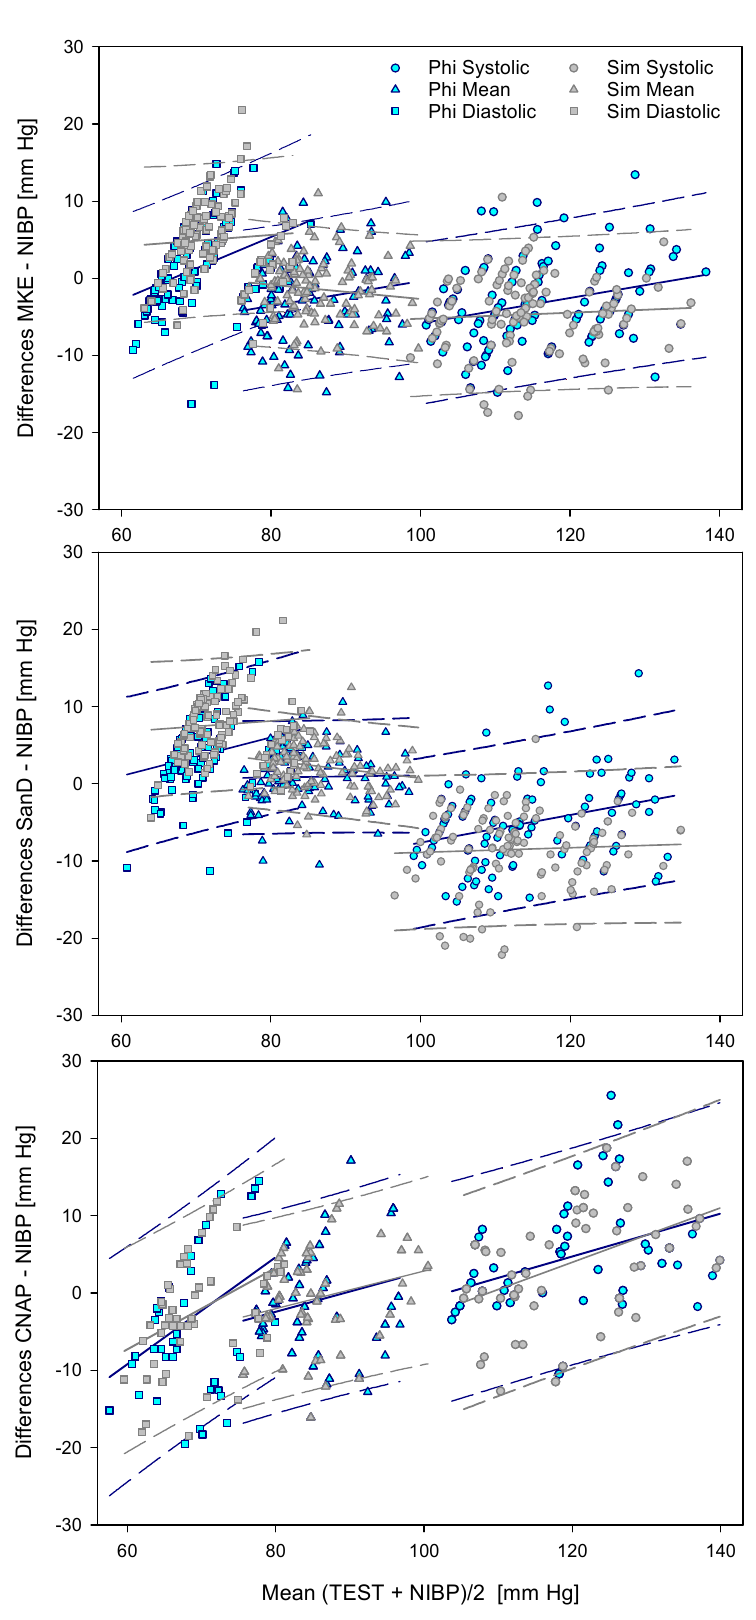
Figure 4. Plots according to Bland and Altman. An entry of bias and limits of agreement was dispensed with in favor of regressions (solid lines) and prediction intervals (mean dotted lines).